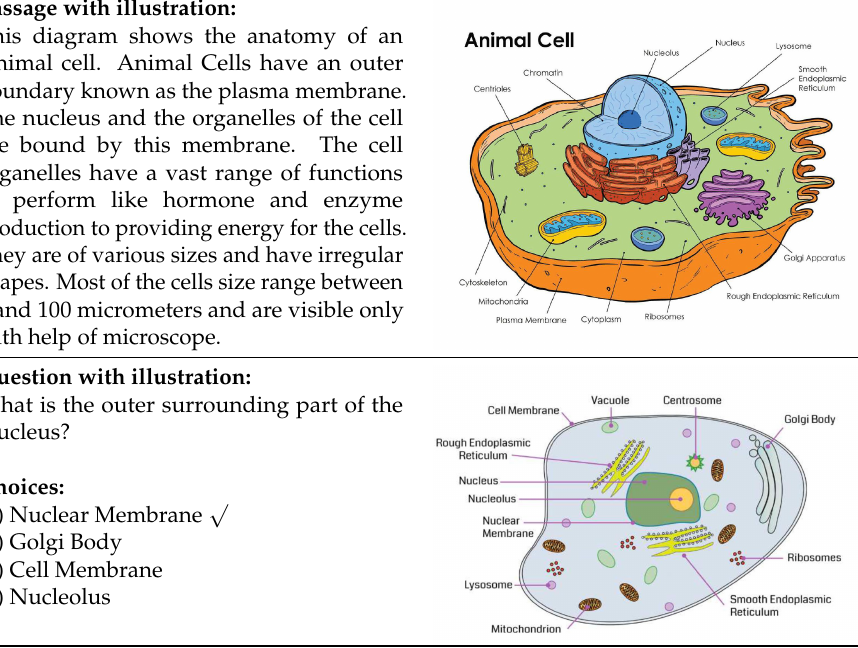
Figure 4. An example of multi-modal MRC task. The illustrations and questions are taken from the TQA [31]